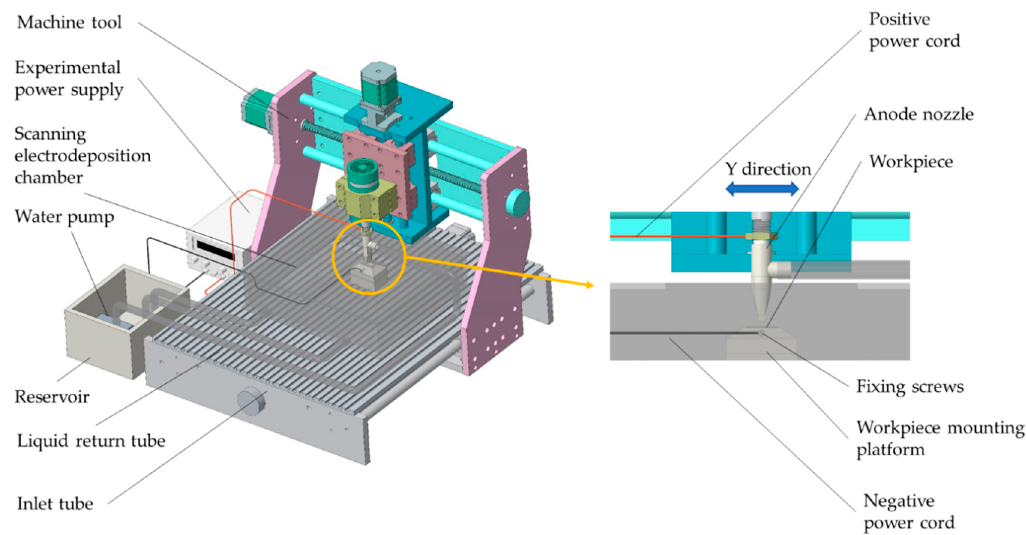
Figure 1. Scanning electrodeposition test device.